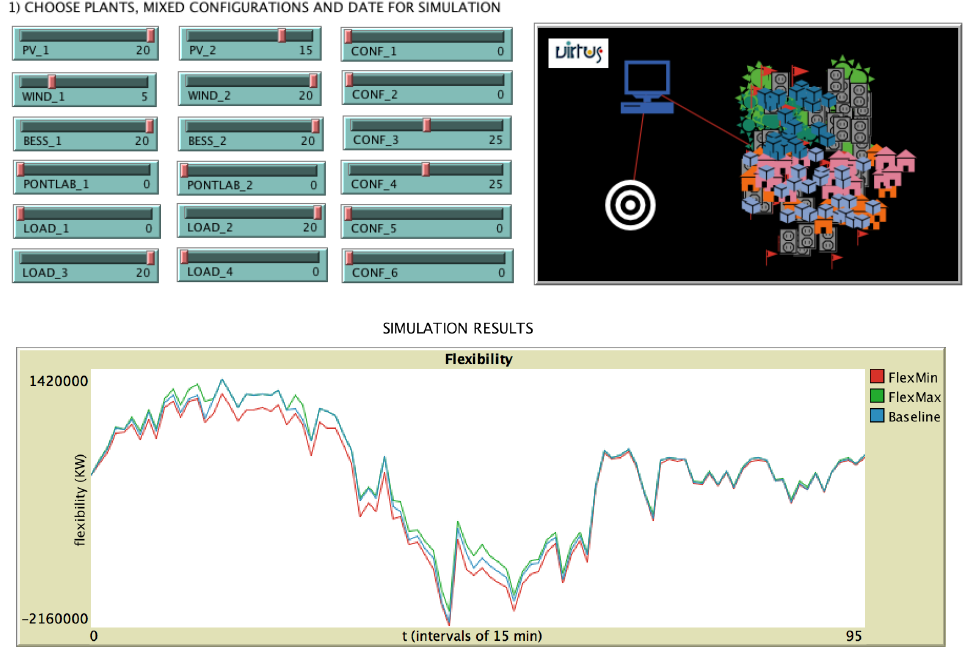
Figure 20. ( Up ) Case study 4 setting. ( Down ) Case study 4 results.